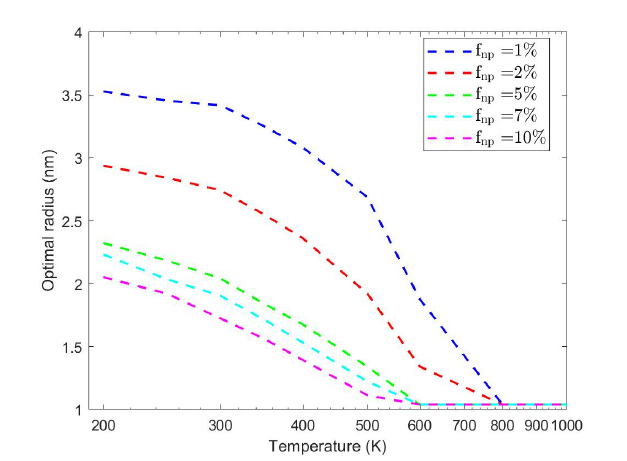
Figure 12. Optimal radius versus T for various volume fractions of nanoparticles in Si 0.7 Ge 0.3 .